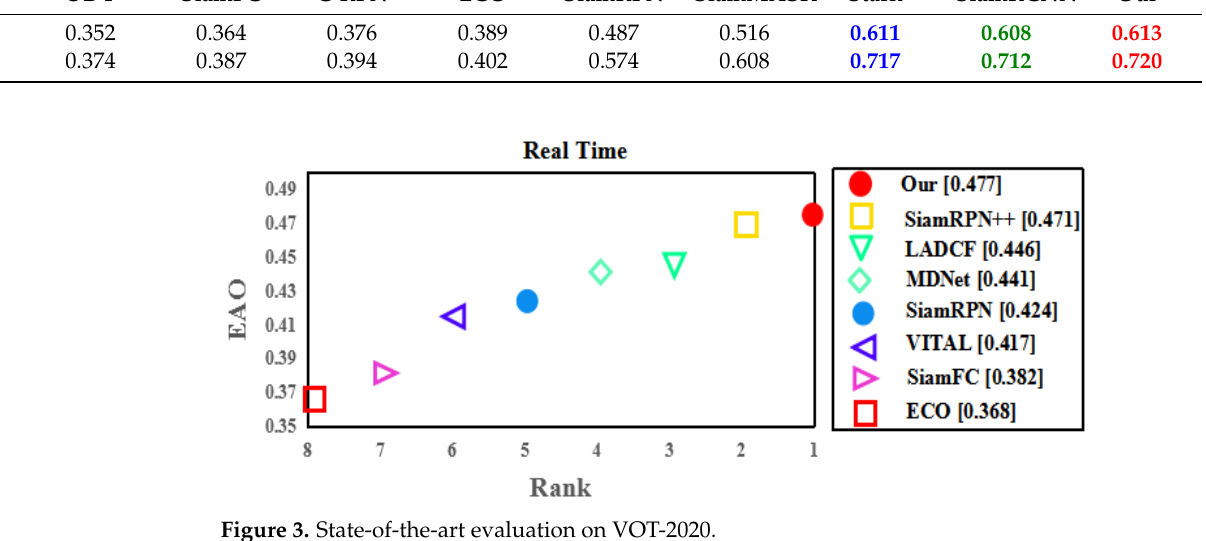
Sensors 2022 , 22 , x FOR PEER REVIEW